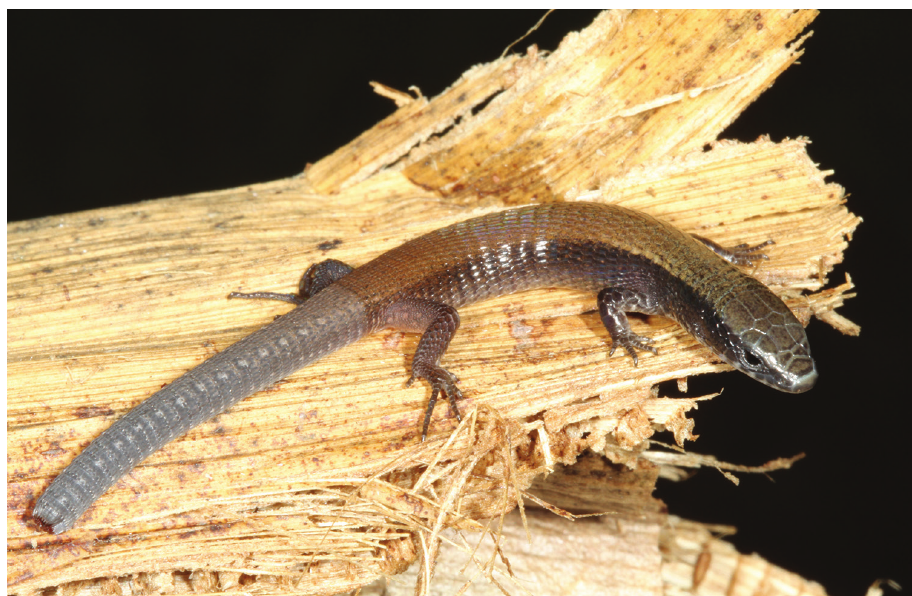
Figure 3. Neotype of Colobosaura kraepelini (SMF 101370) from the vicinity of Altos, Cordillera Department,